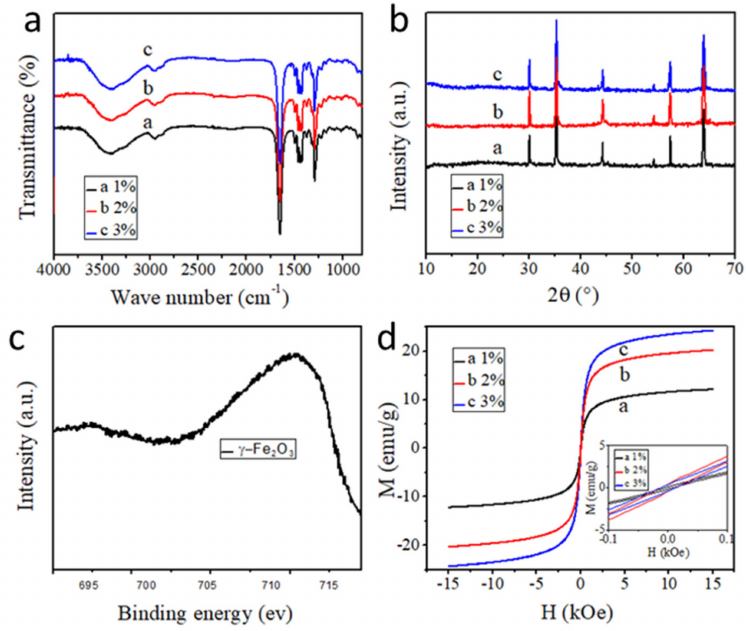
Figure 4. ( a ) FTIR spectra ( b ) XRD patterns, and ( d ) hysteresis loop of PVP / γ -Fe 2 O 3 nanofibers fabricated by MES with di ff erent γ -Fe 2 O 3 contents. ( c ) High-resolution Fe 2p XPS spectrum of PVP / γ -Fe 2 O 3